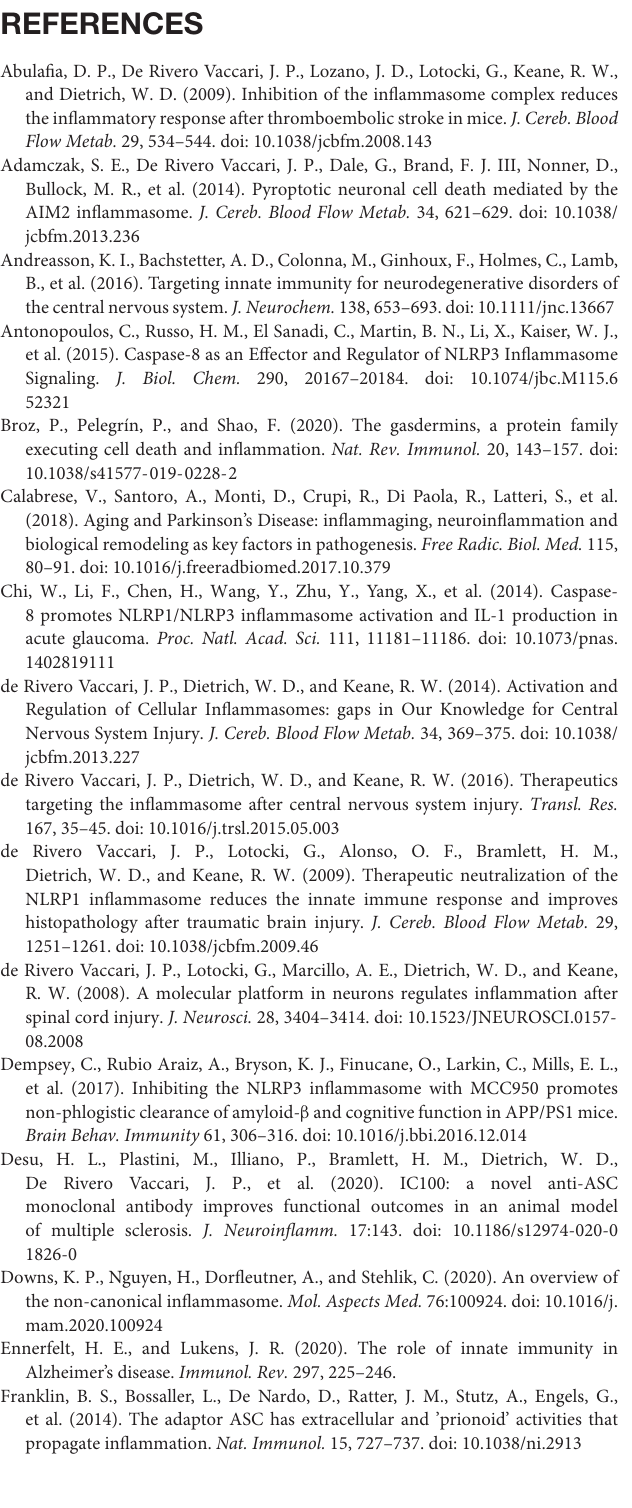
ASC, caspase-8, NLRP1 and caspase-1 as negative controls (C) . 3 m, 3 months; Sal, Saline; mAb, Monoclonal antibody; Pre-Cl, pre-cleared lysate. Supplementary Figure 2 | Inflammasome proteins are elevated in cortical neurons of aged mice. Aged mice were treated with anti-ASC (10 mg/kg) and